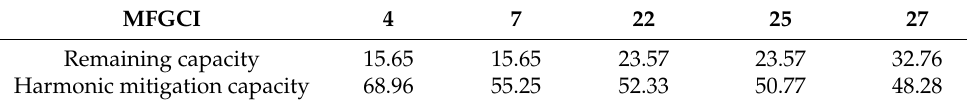
Table 8. Capacity of each MFGCI involved in harmonic mitigation